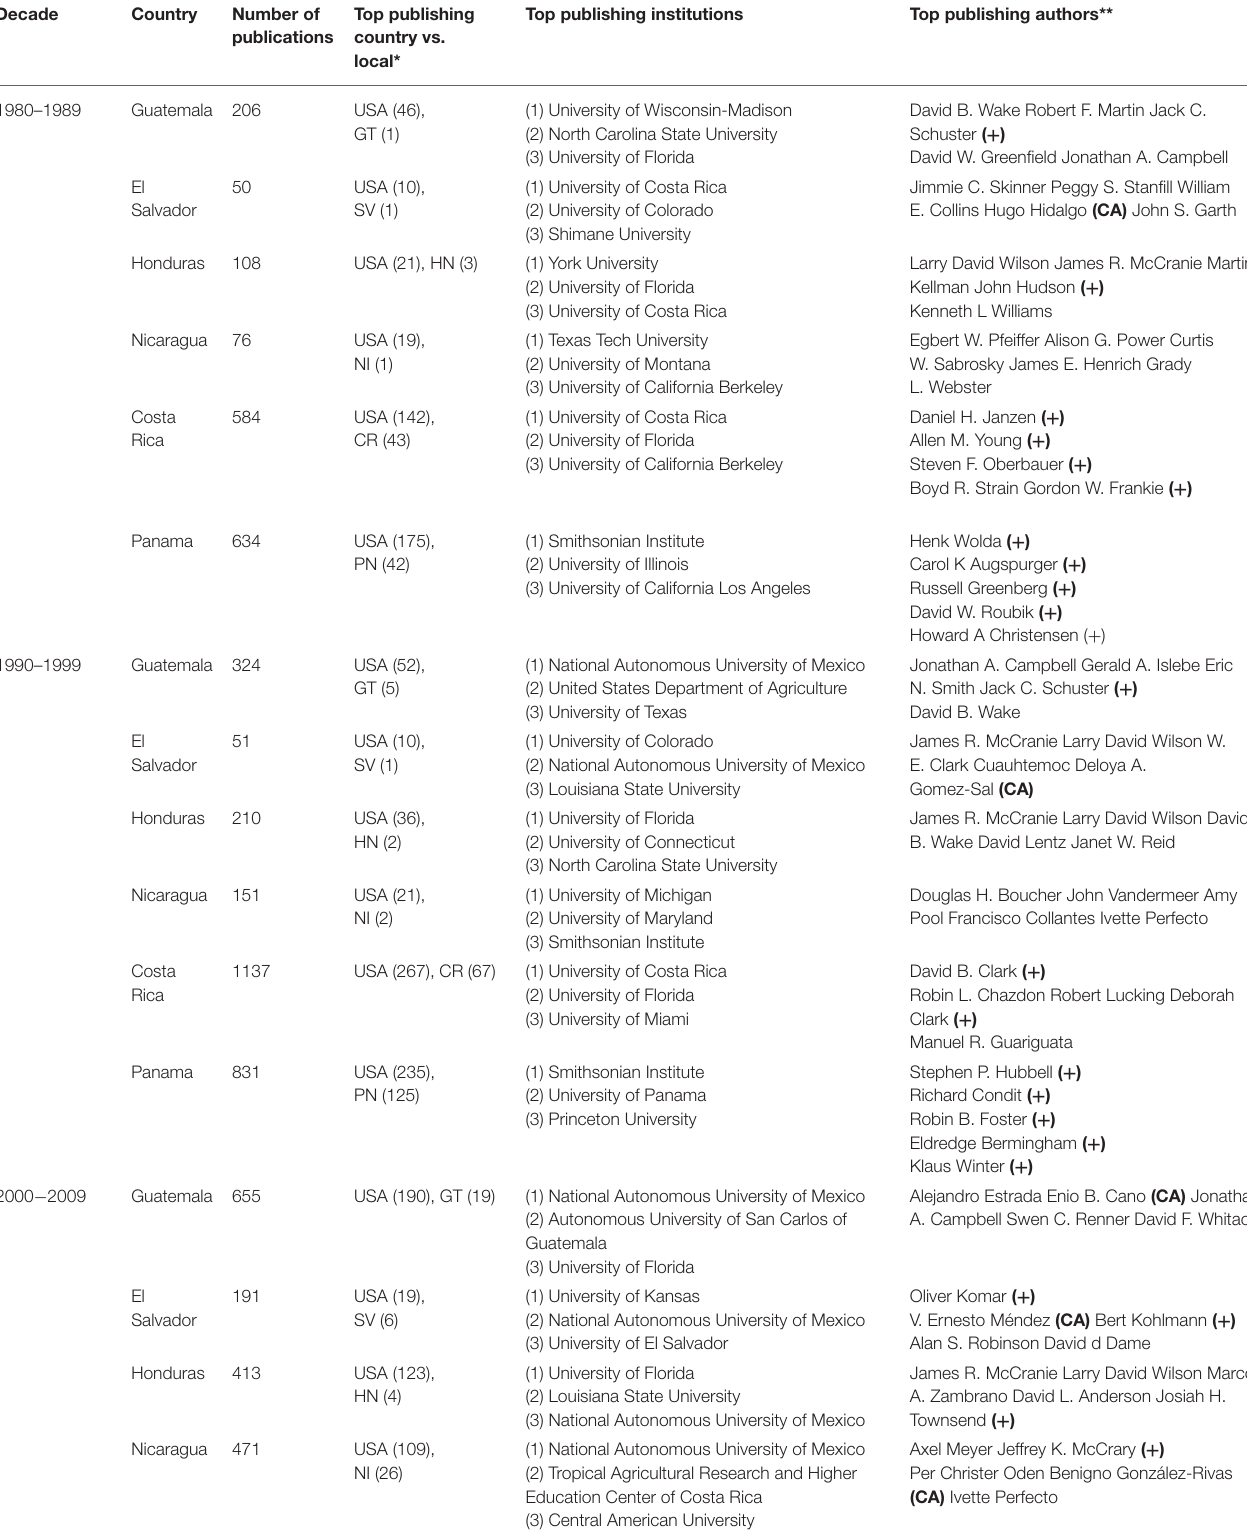
TABLE 1 | Bibliometric analysis of scientific production in biodiversity topics per decade from 1980 to 2020 in Central America. Decade Country Number of Top publishing publications country